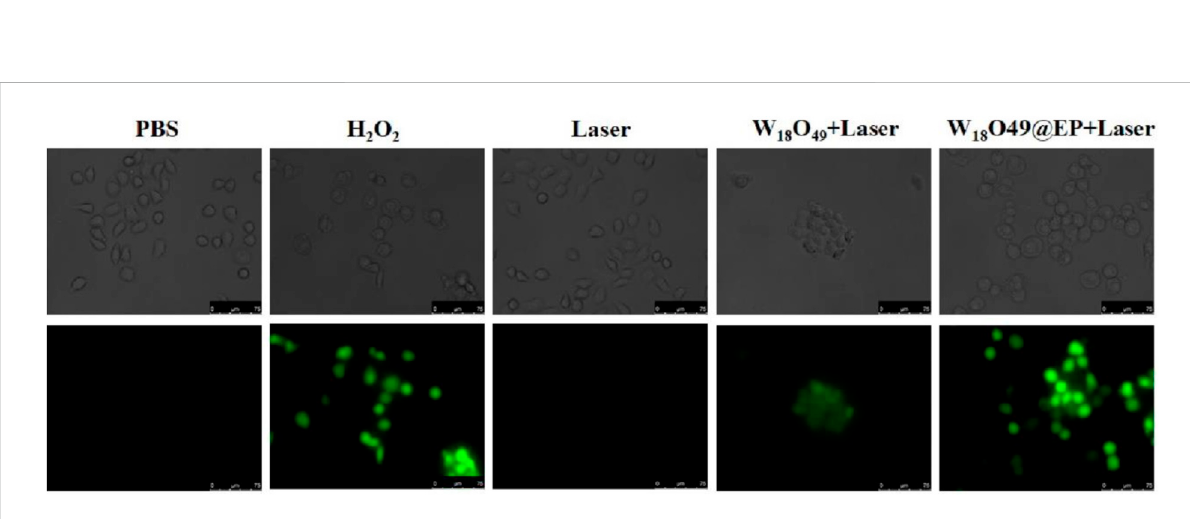
Intracellular production of ROS after different